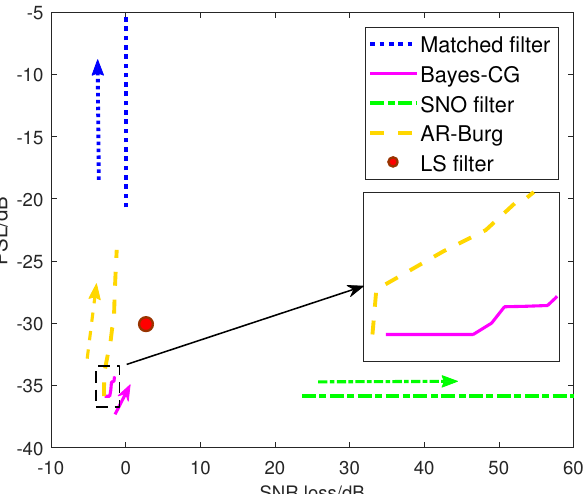
Figure 8. PSL versus SNR loss under different sidelobe reduction approaches with the decreasing bandwidth occupancy ratio η , where ω =